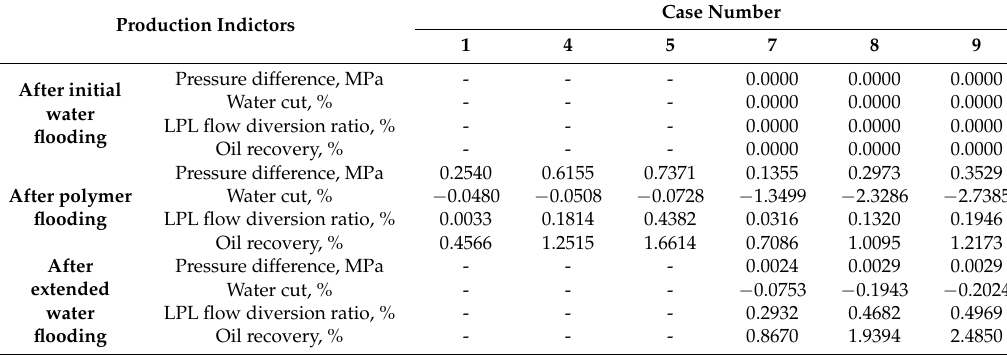
Table 9. Production indicator reductions of Cases 1, 4 and 5 vs. Case 3, and those of Cases 7–9 vs. Case